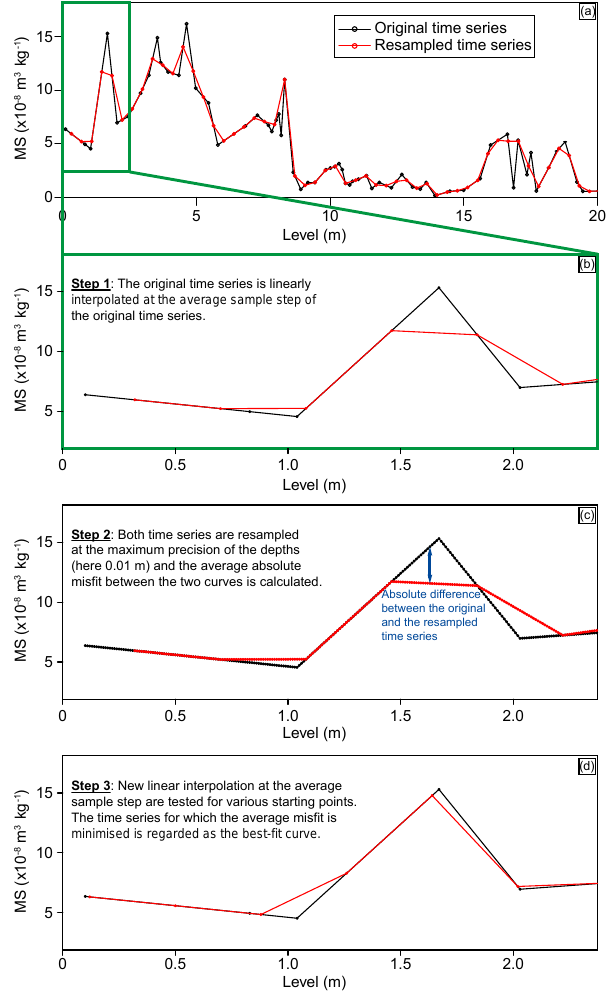
Figure A1. Scheme of the procedure of the optimised linear inter- polation of time series.